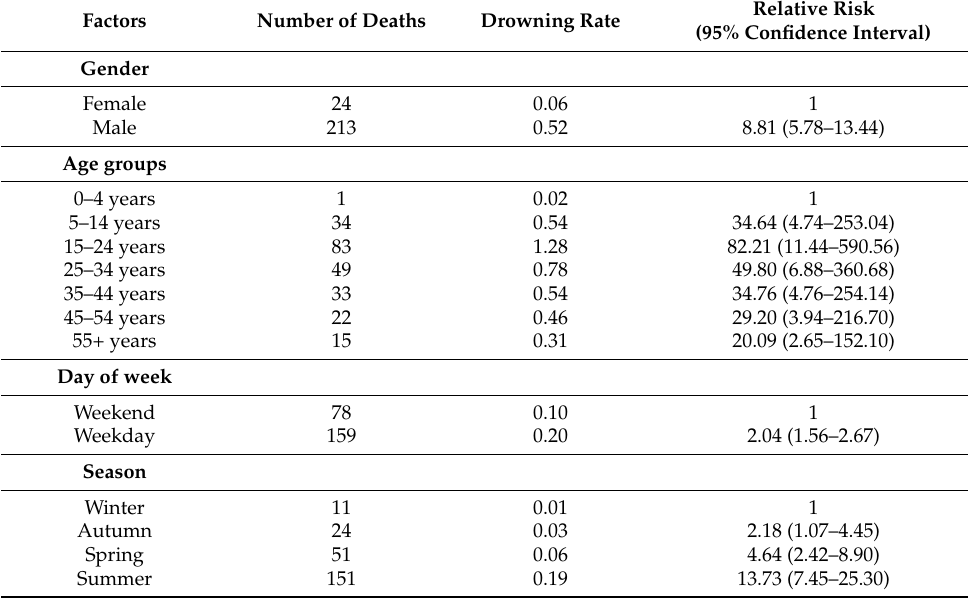
Table 4. Relative risk (95% confidence interval) by gender, age group, day of the week and season of drowning